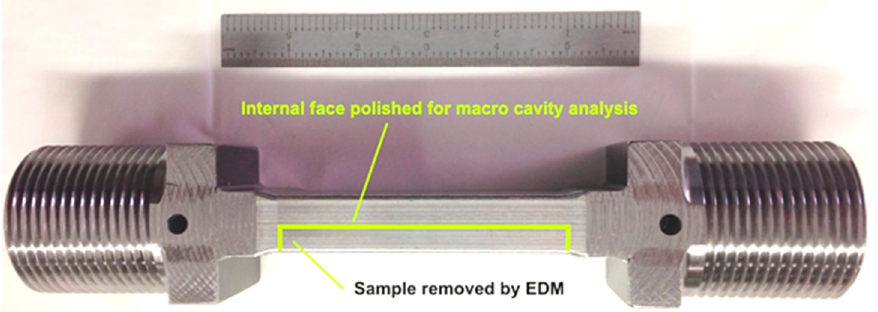
Figure 8. Example of Feature Creep Tests Used in the Evaluation of Damage in the Heat Affected Zone of Grade 91 Steel. Note: the feature test sample contains the entirely of the weld, the HAZ on both sides of the weld and sufficient base metal to promote stress states in the weldment.